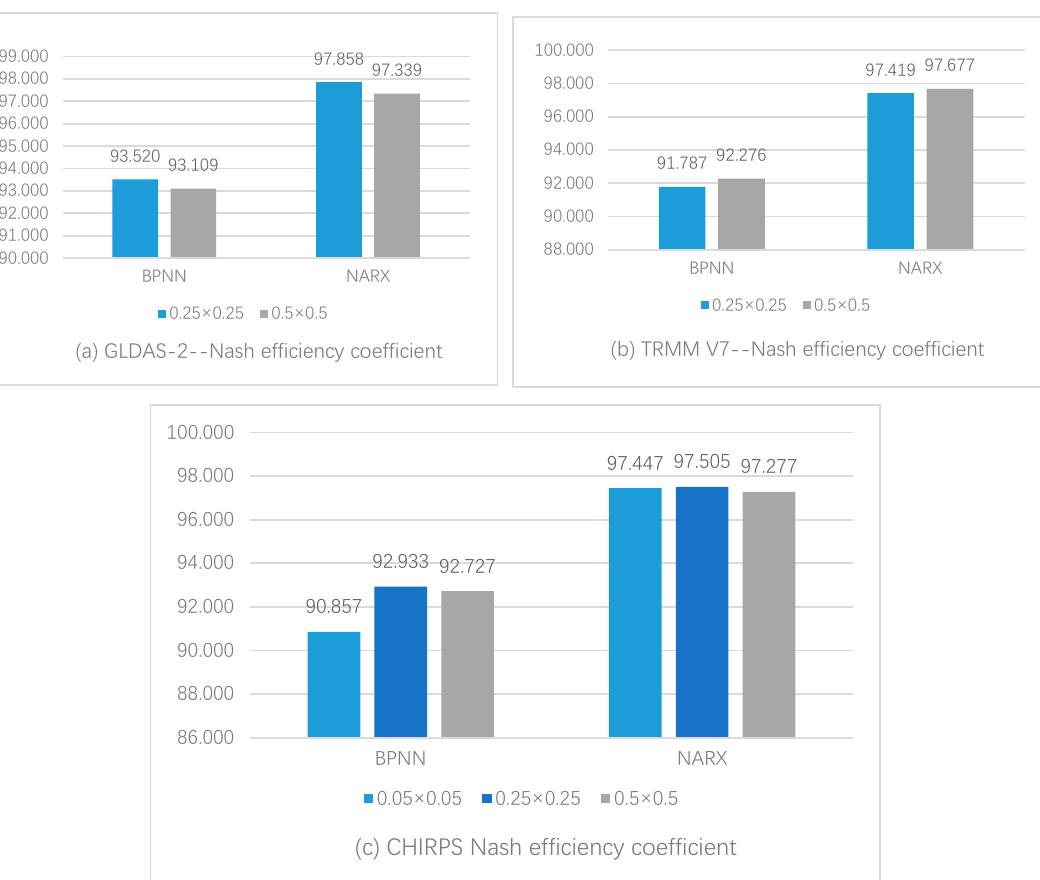
Figure 7. Comparison of performance of the water level modeling using different resolutions. ( a ) Nash efficiency coefficient for water level prediction using GLDAS-2 data. ( b ) Nash efficiency coefficient for water level prediction using TRMM-V7 data. ( c ) Nash efficiency coefficient for water level prediction using CHIRPS data.